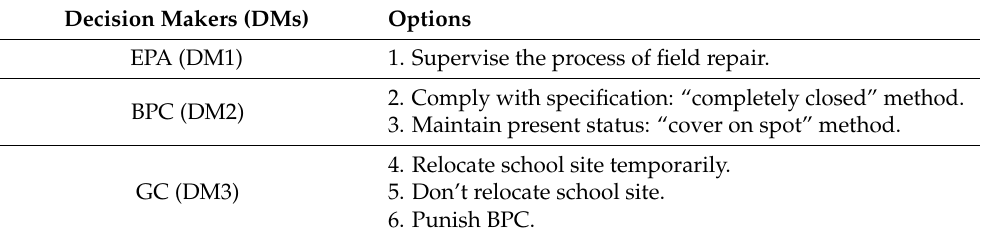
Table 2. DMs and options in the Changzhou conflict.